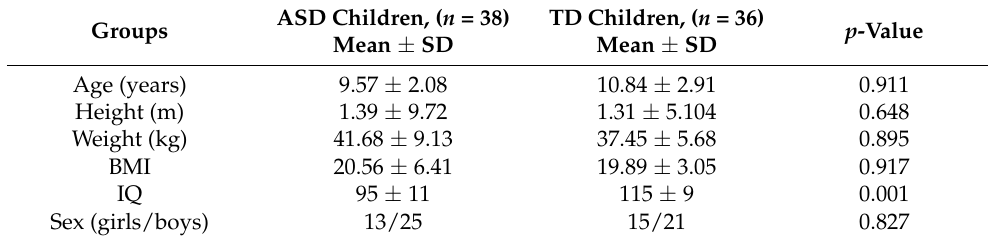
Table 1. The demographic characteristics of ASD and TD children.